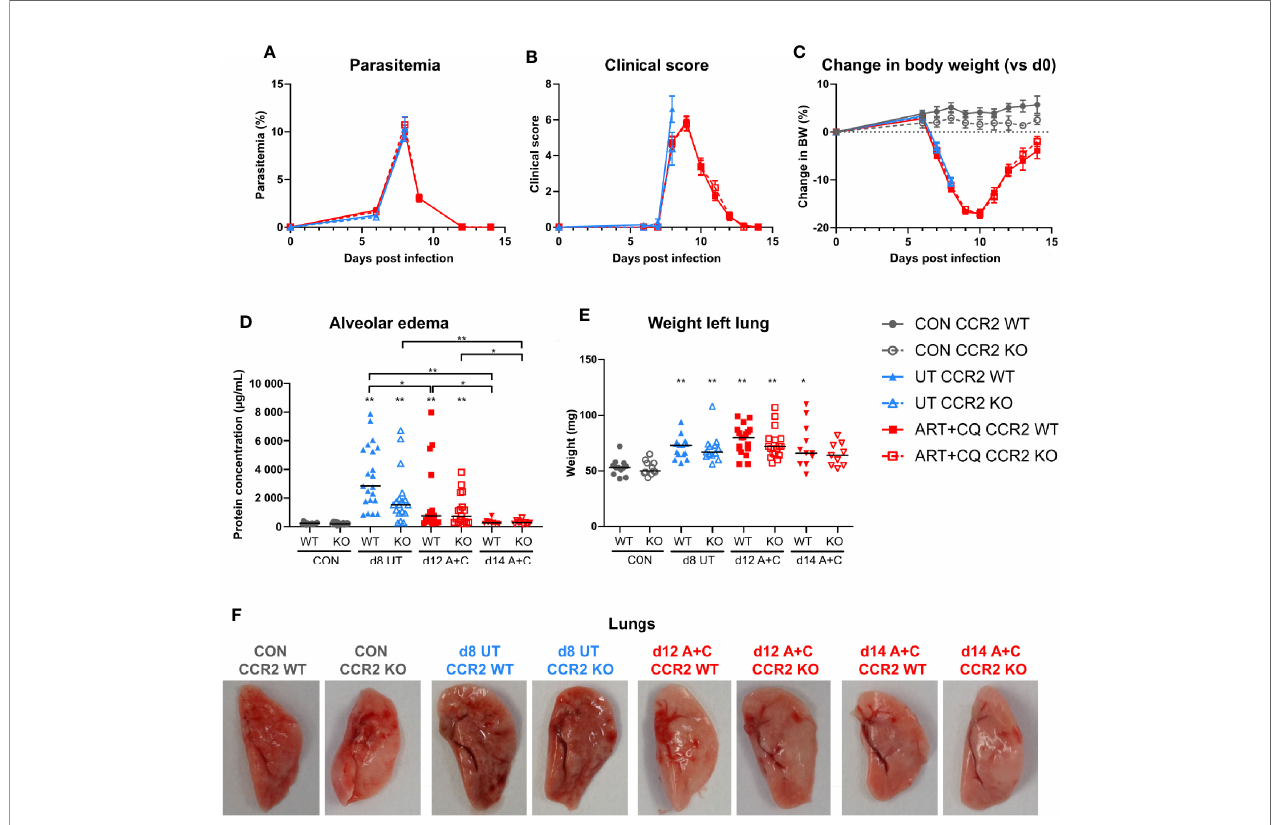
FIGURE 6 | The CCR2 knock-out had no effect on the development and the resolution of malaria-associated acute respiratory distress syndrome (MA-ARDS). CCR2 WT and CCR2 KO C57BL/6 mice were infected with Pb NK65. Mice were injected daily from 8 until 12 days p.i. with 10 mg/kg ART + 30 mg/kg CQ. (A) Parasitemia was determined daily using Giemsa-stained blood smears. (B) The clinical score was monitored daily starting at 6 days p.i. (C) The change in body weight was calculated compared to day 0 p.i. starting at 6 days p.i. (A – C) Compilation of fi ve experiments. Data are shown as means ± SEM. n=6 – 12 for CON CCR2 WT, n=5 – 11 for CON CCR2 KO, n=15 for UT CCR2 WT, n=13 for UT CCR2 KO, n=10 – 32 for ART+CQ CCR2 WT, n=7 – 27 for ART+CQ CCR2 KO. (D, E) Lung pathology was quanti fi ed based on the protein concentration in the BALF (D) and the weight of the left lung (E) at 8 days p.i. for the UT group and at 12 and 14 days p.i. for the ART+CQ group. Compilation of fi ve experiments. Each symbol represents data of an individual mouse. n=12 – 16 for CON CCR2 WT, n=11 – 15 for CON CCR2 KO, n=15 – 21 for UT CCR2 WT, n=13 – 18 for UT CCR2 KO, n=18 for ART+CQ CCR2 WT at 12 days p.i., n=17 for ART+CQ CCR2 KO at 12 days p.i., n=10 – 11 for ART+CQ CCR2 WT at 14 days p.i., n=9 for ART+CQ CCR2 KO at 14 days p.i. (F) Representative pictures of the left